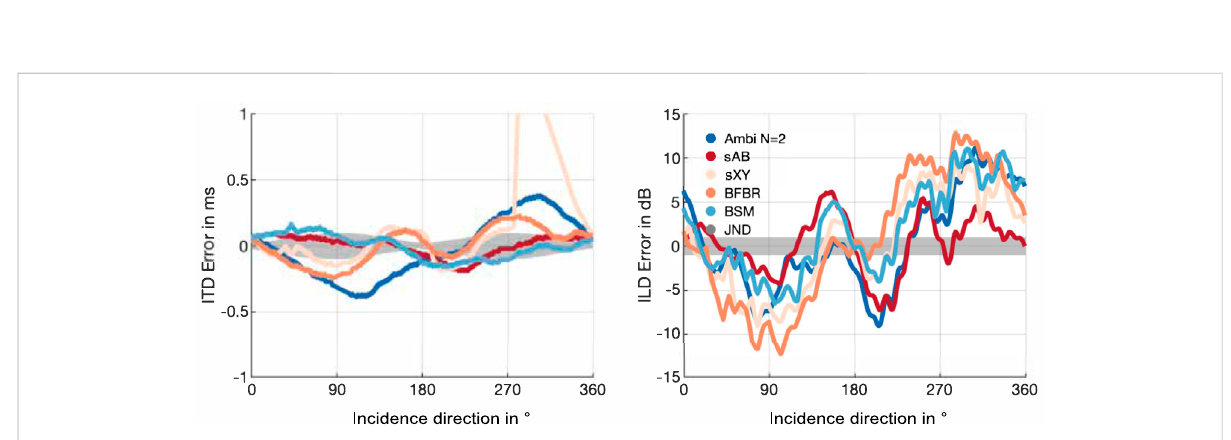
FIGURE 9 ITD and ILD errors for the glasses array using different binaural reproduction approaches. The shaded gray areas represent JNDs.